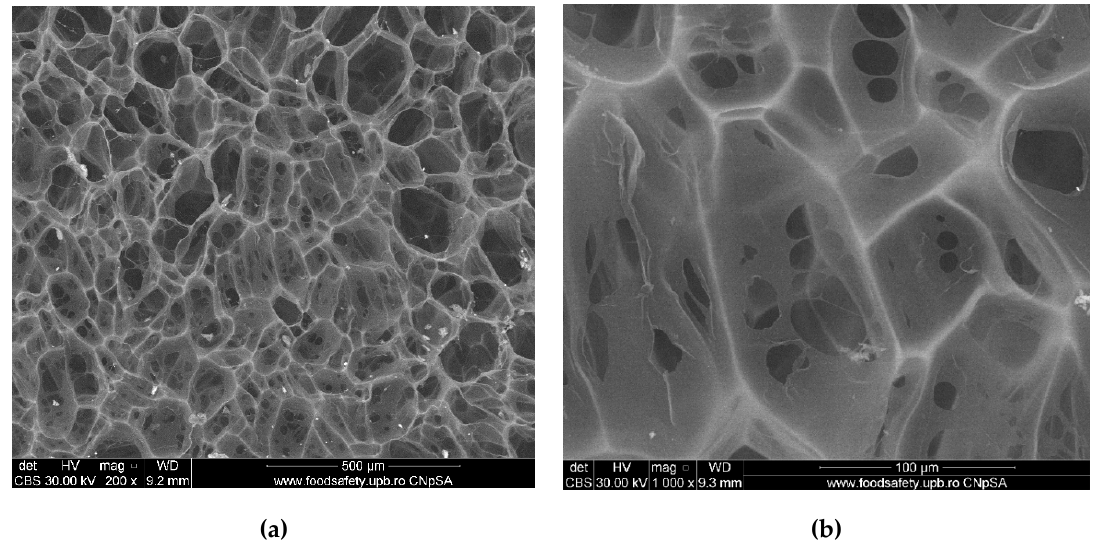
Figure 7. SEM micrographs ( a -general aspect, b -an up-close detail) of freeze-dried chitosan and gelatin sample (CS_Gel).